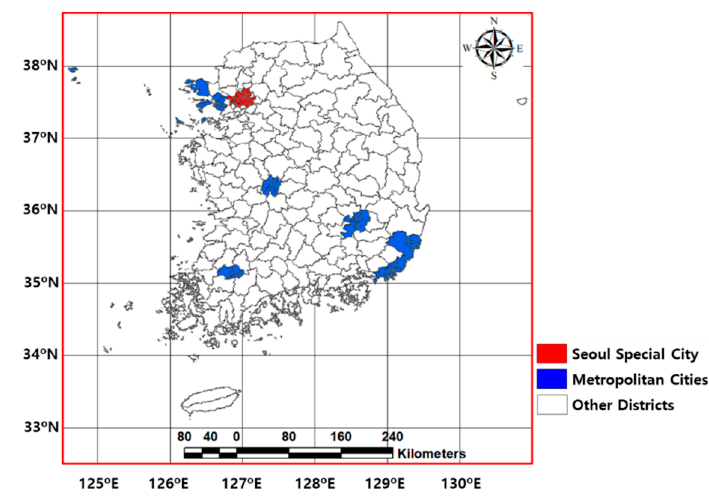
Figure 1. The location map of the study site with administrative districts in the Republic of Korea.